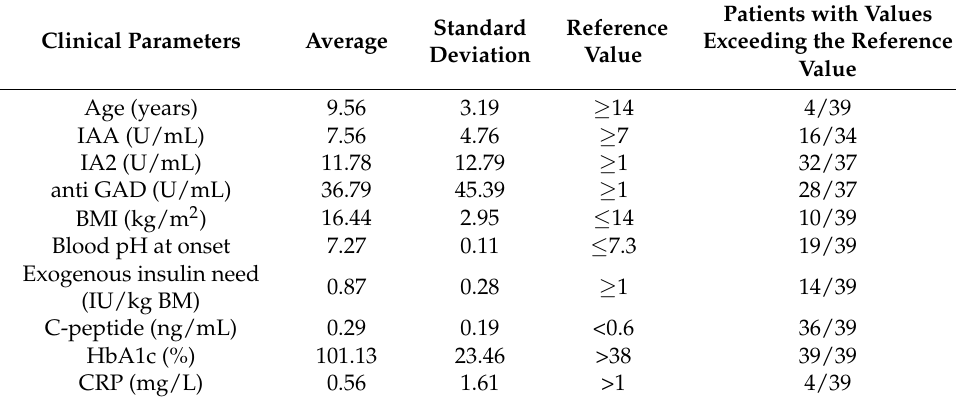
Table 2. Clinical parameters recorded for T1D patients at hospital admission and respective reference values for T1D diagnosis.